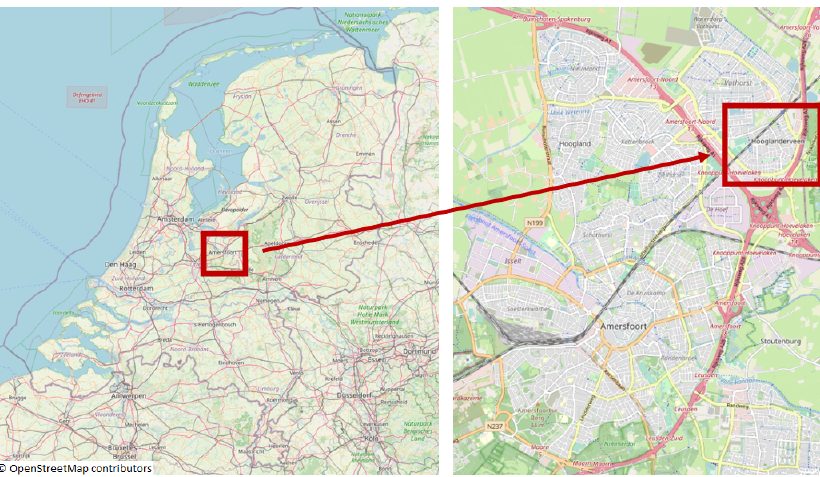
Figure 2. Location of the study area of Hooglanderveen in Amersfoort, The